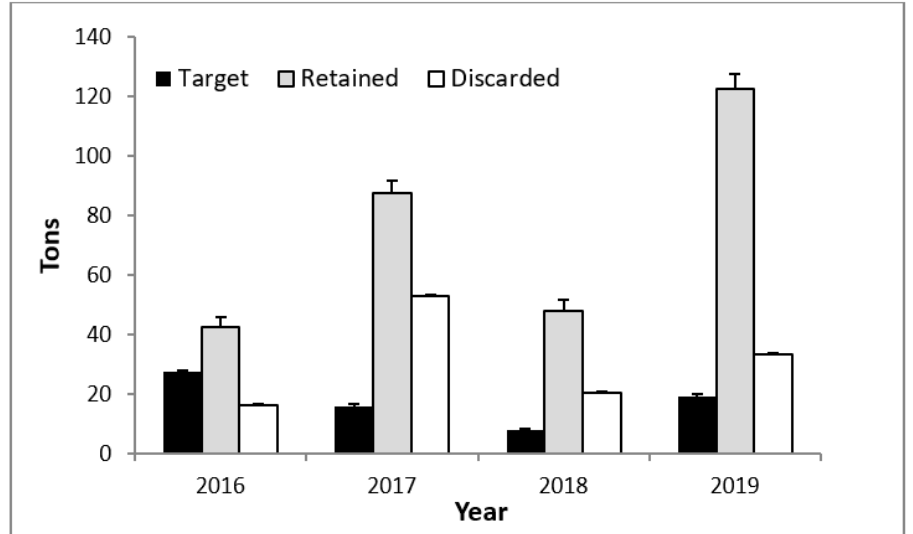
Figure 5. Trawl-fishery target retained and discarded catch ( ± SE) recorded by observers between 2016 and 2019 in Malindi–Ungwana Bay. Table 2. Top-ten species by weight of retained and discarded species recorded from 2016 to 2019. Weight in kg